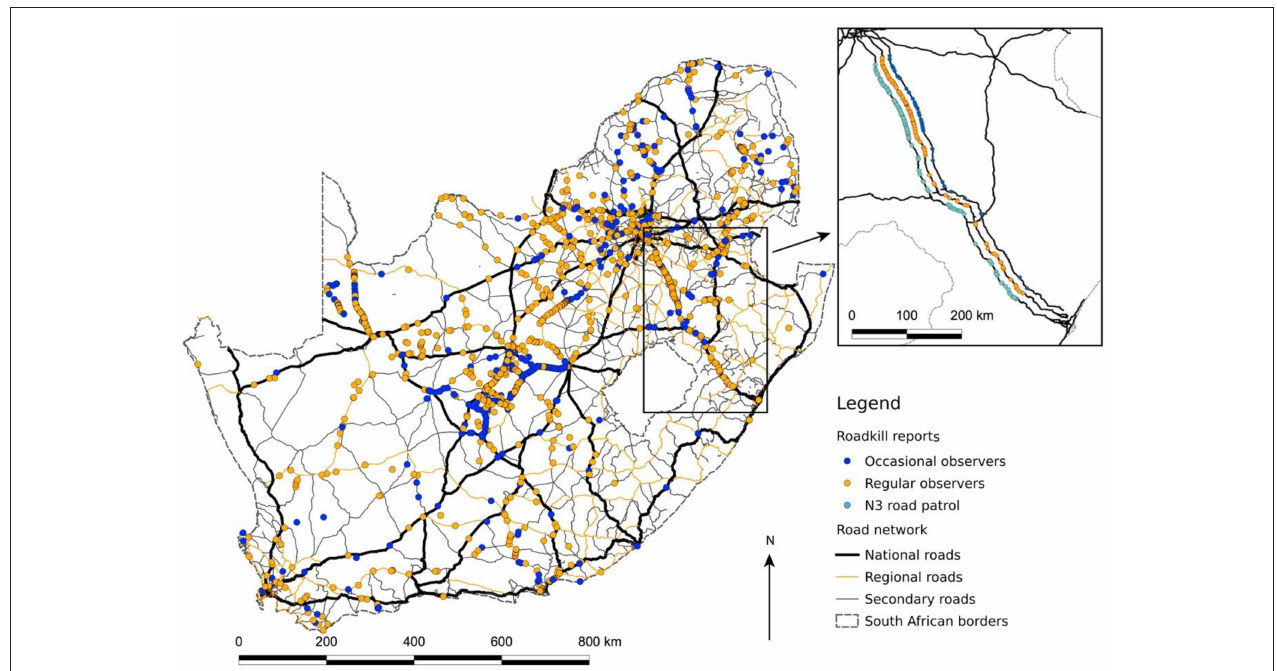
FIGURE 1 | Spatial distribution of roadkill reports collected from occasional (dark blue dots) and regular (yellow dots) reporters in South Africa and along the N3 (insert) where roadkill reports were also provided by trained personnel conducting regular road patrols (light blue